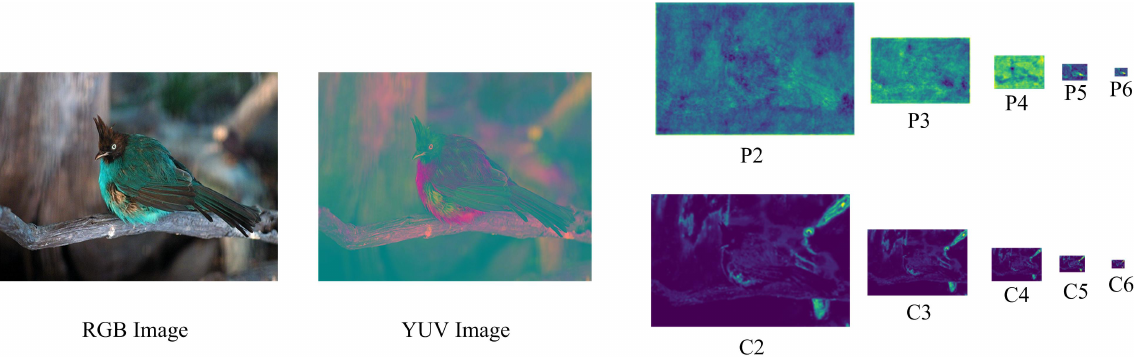
Figure 4. Test image and multi-level